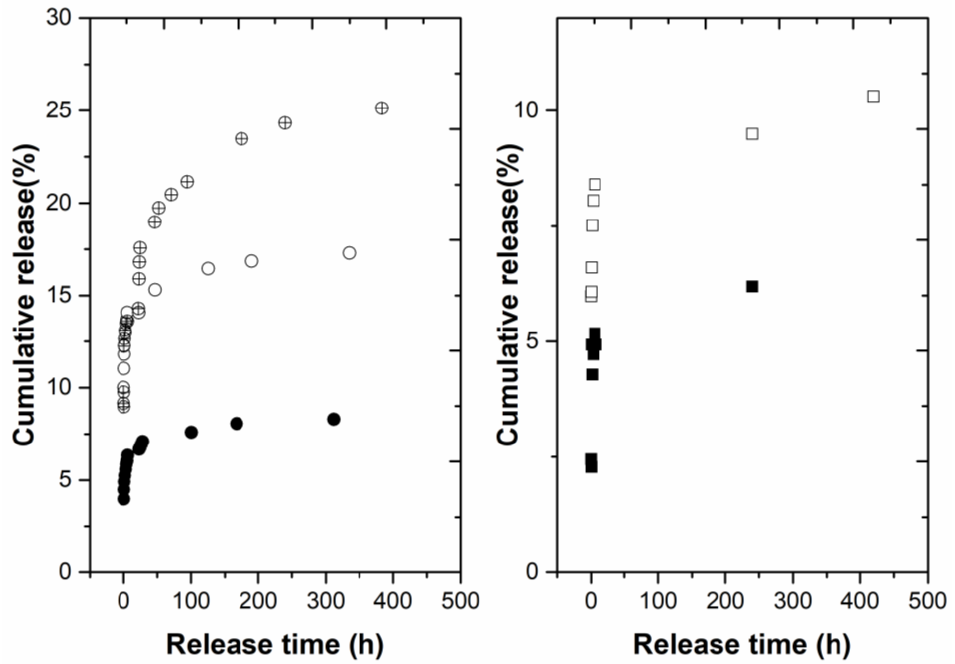
Figure 7. Cumulative release of baicalin (left Figure) and baicalein (right Figure). Empty symbols for adsorbed flavonoids and filled symbols for in situ incorporated ones (at 0.05 mM polyphenol initial concentration). Crossed open circles correspond to baicalin release after replacing full medium with fresh PBS after 22 h.